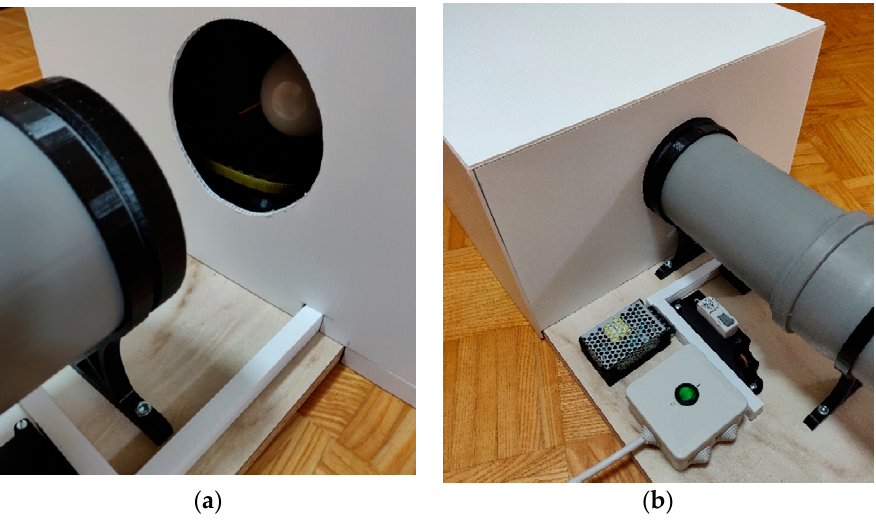
Figure 7. Installing the chamber on the measuring system: ( a ) Before installation; ( b ) After installa- tion.